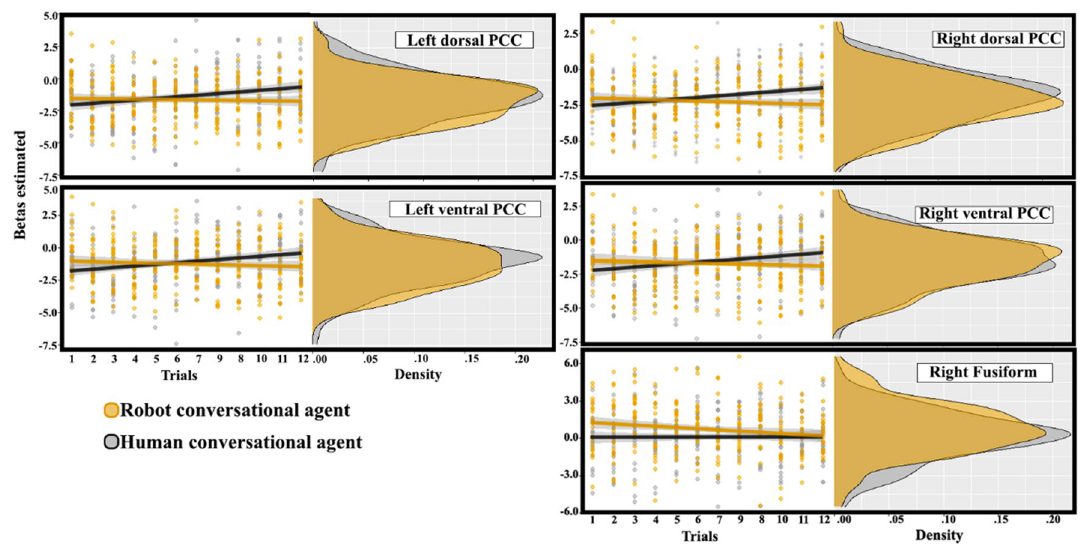
Figure 3. BOLD signal as a function of the type of interactor (human vs robot) and consecutive trials (corresponding to time) in the dorsal and ventral Posterior Cingulate Cortex (PCC)